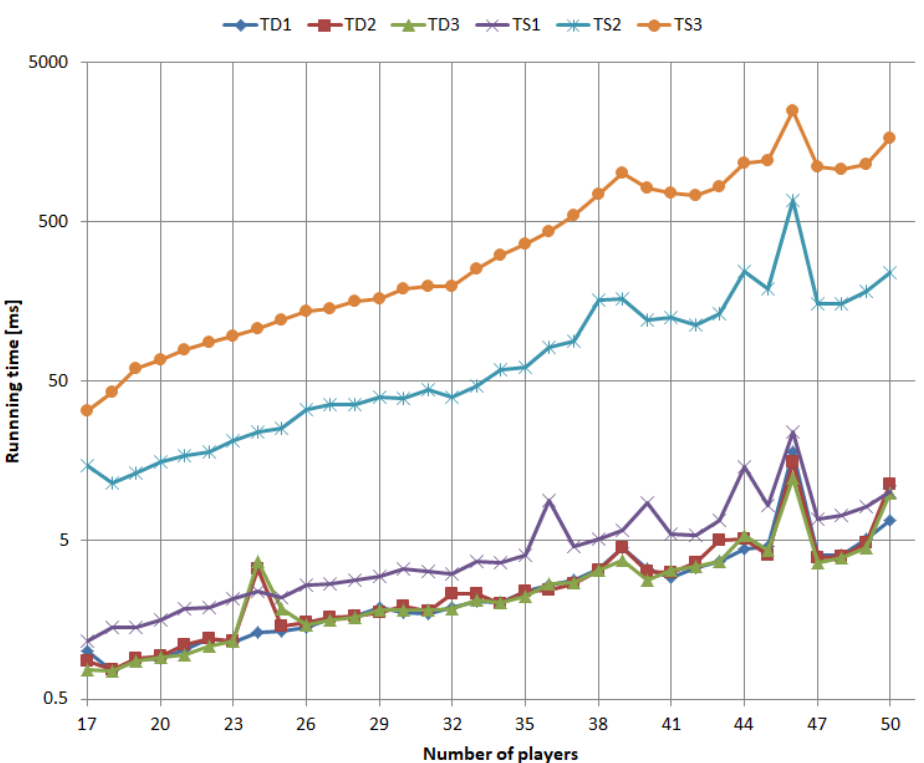
Figure 6. Running times on logarithmic scale of sub-optimal algorithms on different quotations’ sequences for a variable number of